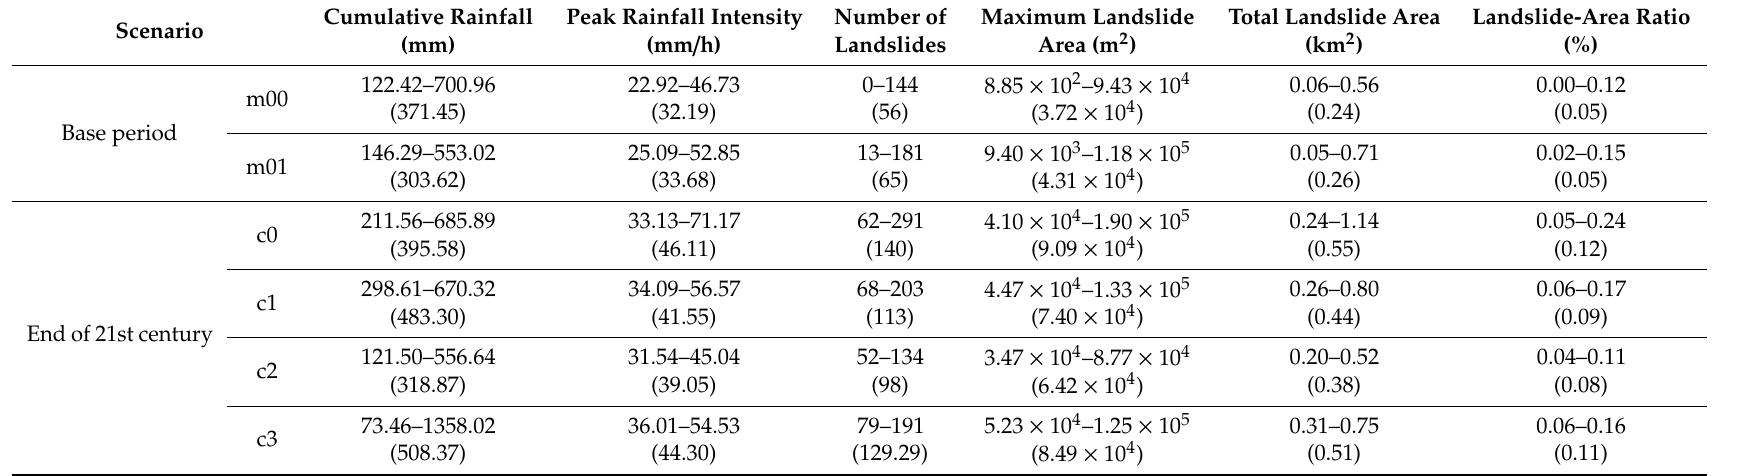
Table 3. The range of average rainfall conditions and possible landslide characteristics in the Xindian River catchment during top 15% typhoon events. “()” is the average value of a